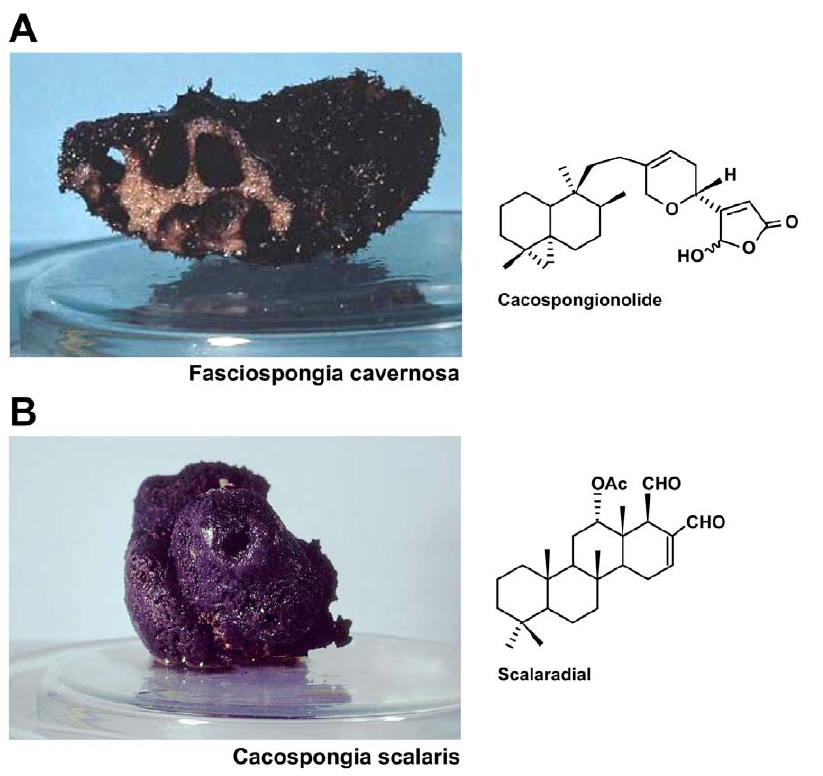
Figure 1. Cacospongionolide and Scalaradial: structures and original sponges. Chemical structures of cacospongionolide and scalaradial isolated from marine sponges Fasciospongia cavernosa and Cacospongia scalaris , respectively.